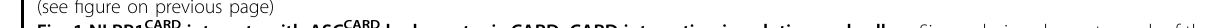
Fig. 1 NLRP1 CARD interacts with ASC CARD by homotypic CARD – CARD interaction in solution and cells. a Size-exclusion chromatograph of the MBP-ASC CARD /NLRP1 CARD complex. ASC CARD was fused with an N-terminal His-tag and incubated with untagged NLRP1 CARD , which was fi rst puri fi ed by Ni-af fi nity chromatography. The complex eluted in the void position on a Superdex TM 24 gel fi ltration column. b A negative-stain EM image of MBP-ASC CARD /NLRP1 CARD complex. c Size-exclusion chromatograph of the MBP-ASC CARD /NLRP1 CARD complex in different salt concentrations. d High salt signi fi cantly disrupted fi lament formation. e Y2H analysis of the NLRP1 CARD and ASC CARD interaction. Yeast cells co-expressing GAL4 DNA-binding domain (BD)-ASC CARD fusion and GAL4 activation domain (AD)-NLRP1 CARD fusion were grown on agar plates lacking leucine and tryptophan (-Leu/- Trp) for transformant growth and lacking histidine, leucine, and tryptophan (-His/-Leu/-Trp) for detecting CARD – CARD interaction. Three individual clones for each combination were plated. ( – ) denotes empty vector control. f Measurement of the protein – protein interaction of wild-type NLRP1 CARD with ASC CARD by the M2H experiment. Luciferase activity in the HEK293T cells was normalized to Renilla and data were presented as the fold of negative control. Mean values ± SEM are representative of three independent experiments. g Structure-based sequence alignment of NLRP1 CARD (NP_127497.1) and ASC CARD (NP_037390.2). Different colors are highlighted to show the interfacial residues involved in the three asymmetric interactions of death domain superfamily. The secondary structure of NLRP1 CARD and ASC CARD are labeled on the top and bottom,